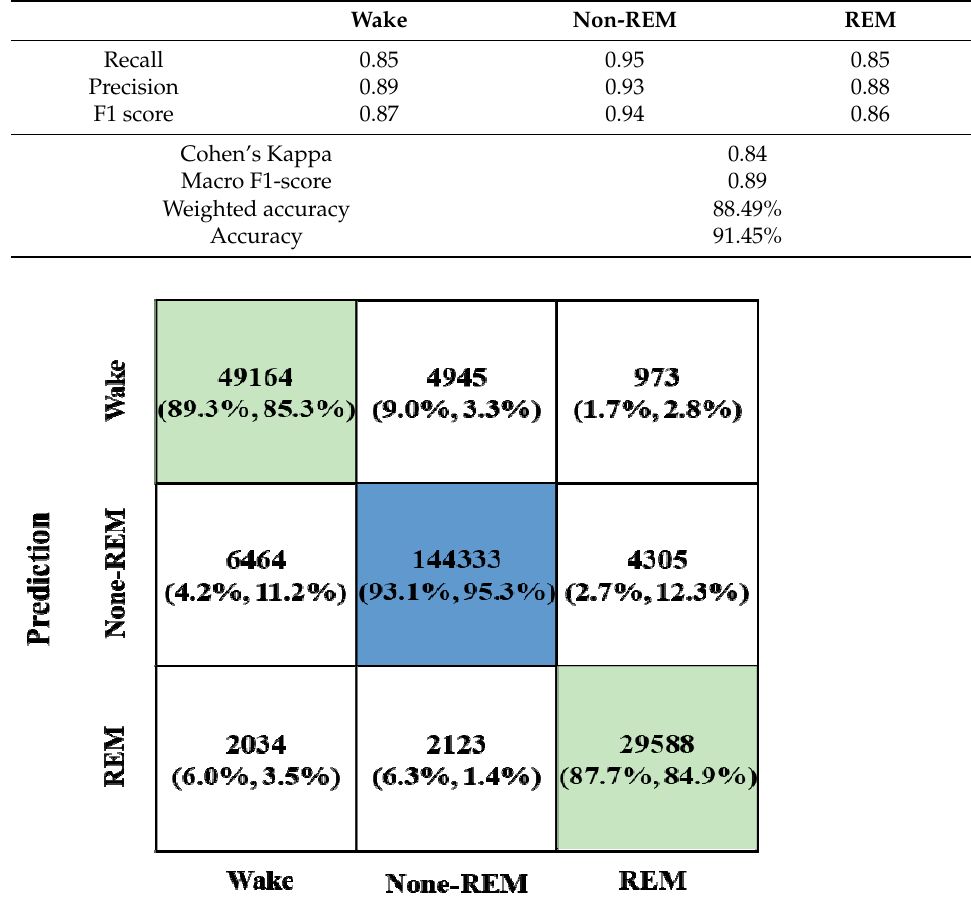
Table 3. Deep learning model performance for three-class sleep scoring.